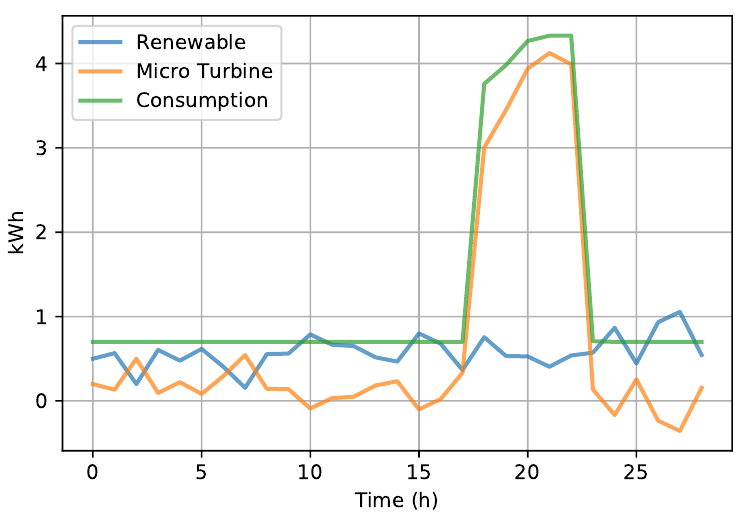
Figure 5. Average power generation managed by the PID controller in the Fog.